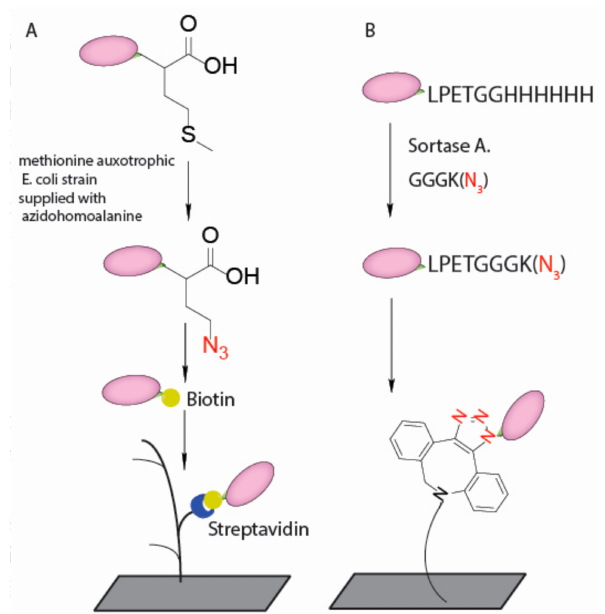
Figure 4. Oriented immobilization scheme for VHHs. ( A ) C-terminal N 3 group introduced by artificial amino acid incorporation followed by conversion to biotin group for streptavidin binding; and ( B ) C-terminal N 3 group attached via sortase mediated transpeptidation followed by site specific attachment on DBCO modified surface.